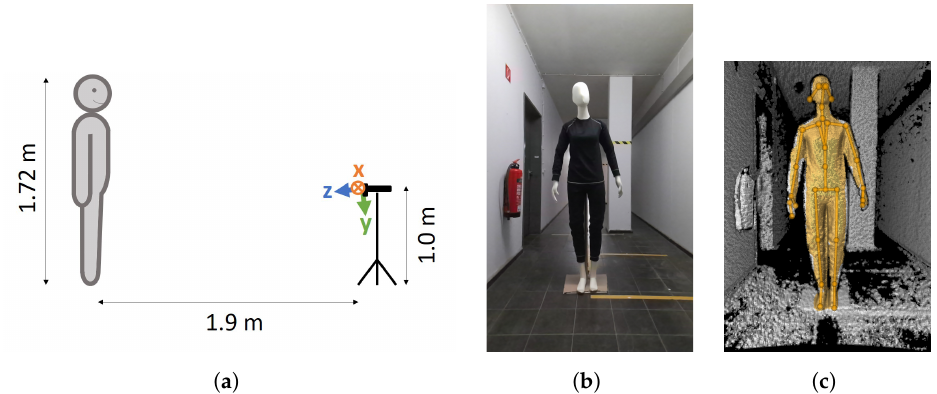
Figure 1. Overview of the experimental setup. ( a ) Schematic setup. In addition, the coordinate system of the depth camera is shown, which is tilted downwards by 6° with respect to the camera’s case. ( b ) Mannequin from the camera’s point of view in a windowless dark room (picture taken with the lights turned on). ( c ) Point cloud of the mannequin with overlaid body tracking. Screenshot of k4abt_simple_3d_viewer from the Azure Kinect Body Tracking